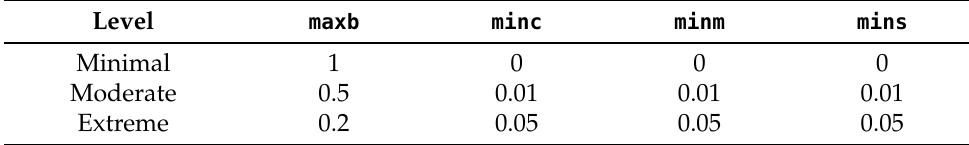
Table 3. Grouping levels and hyperparameter values for